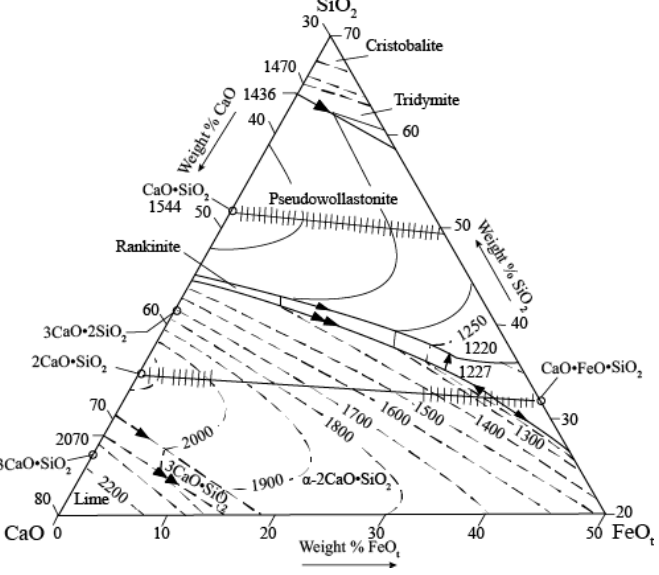
Figure 6. Liquidus surface in the slag system of CaO ‐ SiO 2 ‐ FeO t .